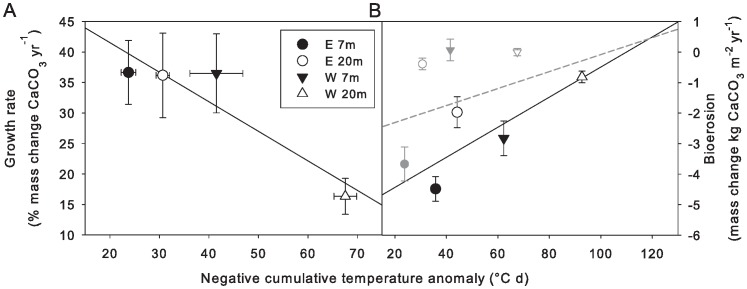
Coral growth and bioerosion as functions of temperature anomaly in west (W) and east (E), 7 m and 20 m depth.Coral growth rate of Porites lutea nubbins at all study sites (n = 20, df = 1, F-value = 4.4, r2 = 0.46, p = 0.039) along the Similan island chain after 12 months exposure (February 2007 to February 2008; see Fig. 4) (A), and bioerosion (calculated mass change in calcium carbonate (CaCO3) corrected for accretion due to fouling organisms) on CaCO3 blocks at the central Similan island Ko Miang (see Fig. 1) after 12 months (grey depiction; February 2007 to February 2008; n = 4, degrees of freedom = 1, F-value = 14.4, r2 = 0.30, p<0.001) and 21 months exposure normalized to 1 year (February 2007 to November 2008; n = 4, degrees of freedom = 1, F-value = 17.9, r2 = 0.58, p<0.001) (see Fig. 5; <0, bioerosion) (B) as functions (GLM) of the cumulative negative temperature anomaly (calculated as °C d) of the respective time period. All values are plotted as mean ± SE.